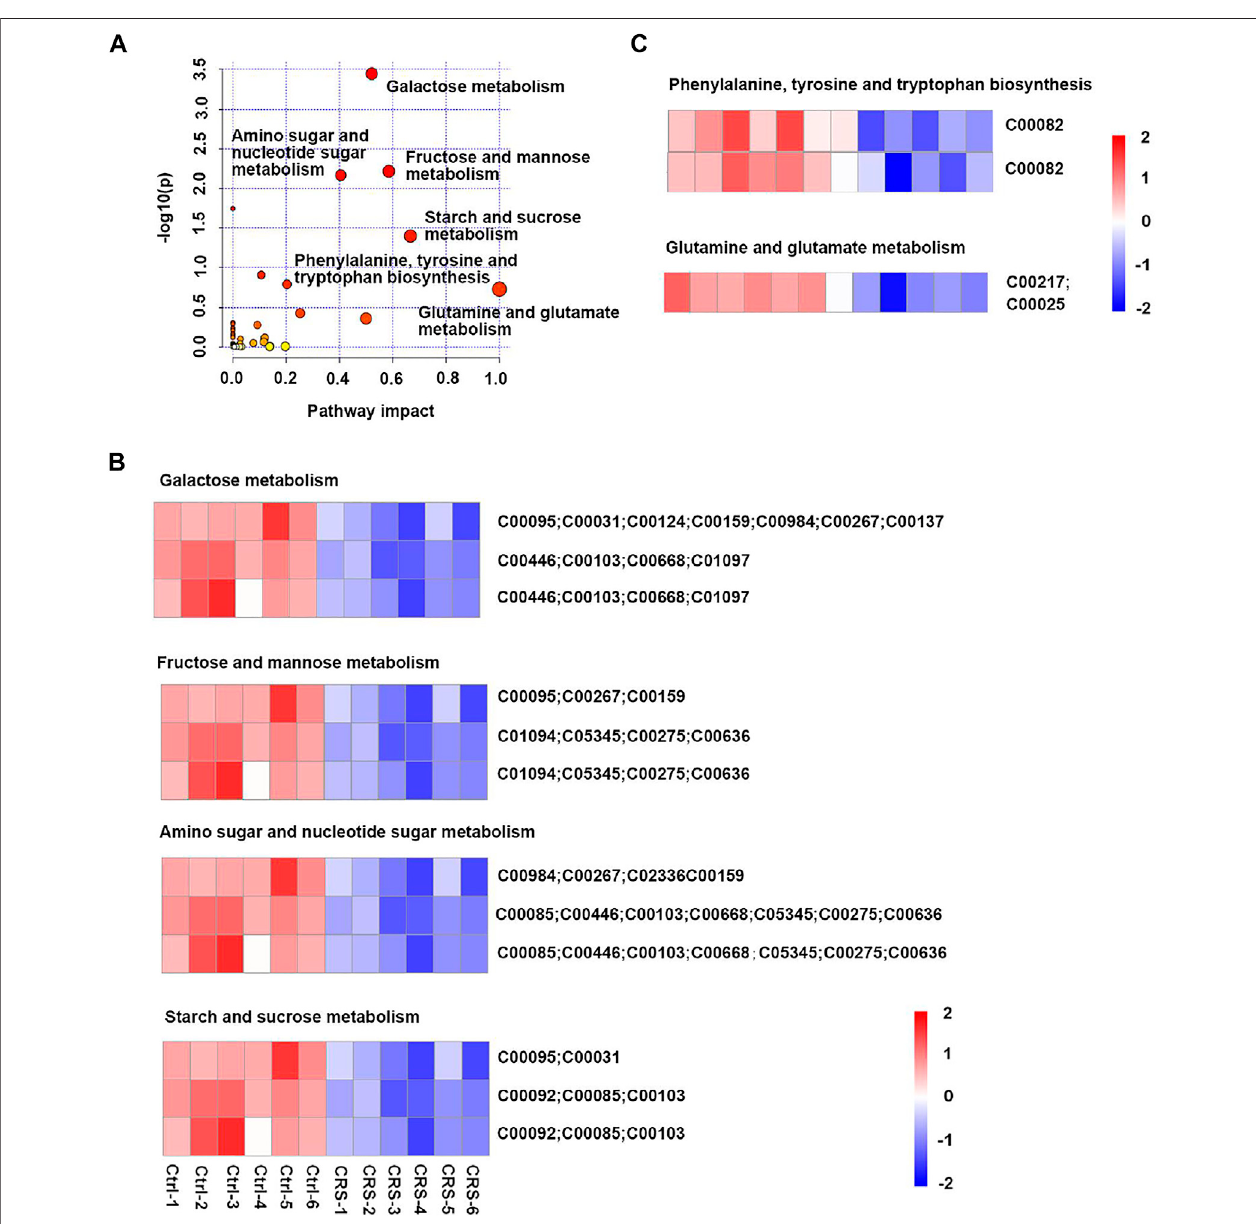
FIGURE 2 | CRS signi fi cantly affects the pro fi les of primary metabolites in skin tissues. (A) Scatterplot of enriched KEGG pathways in primary metabolites when comparingCRSgroupwithcontrolgroupusingtheMetaboAnalyst5.0pathwayanalysismodule.Colorshiftindicateslevelofsigni fi cance,sizeofdotscorrelateswiththe number of differential metabolites. The darker the color and the larger the dot, the stronger is the signi fi cance. Top enriched metabolic pathways were labeled. (B) Heatmap analysis showed differential metabolites in galactose metabolism (C00095, C00031, C00124, C00159, C00984, C00267, C00137, C00446, C00103, C00668, and C01097), fructose and mannose metabolism (C00095, C00267, C00159, C01094, C05345, C00275, and C00636), amino sugar and nucleotide sugar metabolism (C00984, C00267, C02336, C00159, C00085, C00446, C00103, C00668, C05345, C00275, and C00636), starch and sucrose metabolism (C00095, C00031, C00092, C00085, and C00103) between CRS group and control group. The ordinate was the KEGG ID matched to database. (C) Heatmap analysis showed differential metabolites in phenylalanine, tyrosine and tryptophan biosynthesis (C00082), glutamine and glutamate metabolism (C00217, C00025) pathways between CRS group and control group. The ordinate was the KEGG ID matched to database. The color blocks represented the relative expression of metabolites, red represented up-regulation, and blue represented down-regulation.